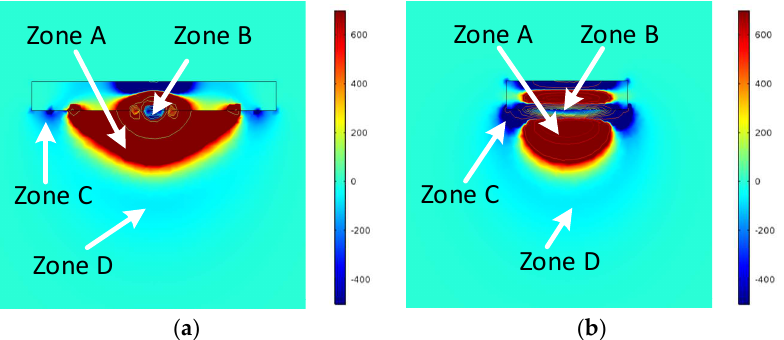
Figure 4. The MSD for the CI sensor shown in Figure 1 ( a ) MSD in Y = 0 plane and ( b ) MSD in X = 0 plane. X = 0